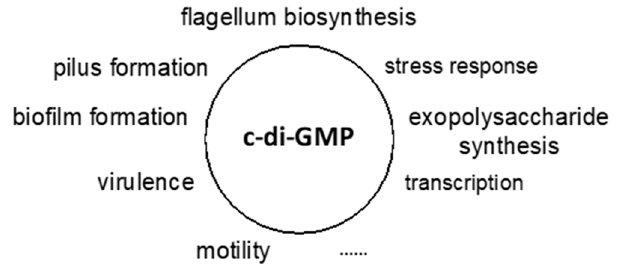
Figure 3. Processes regulated by c-di-GMP signalling networks.